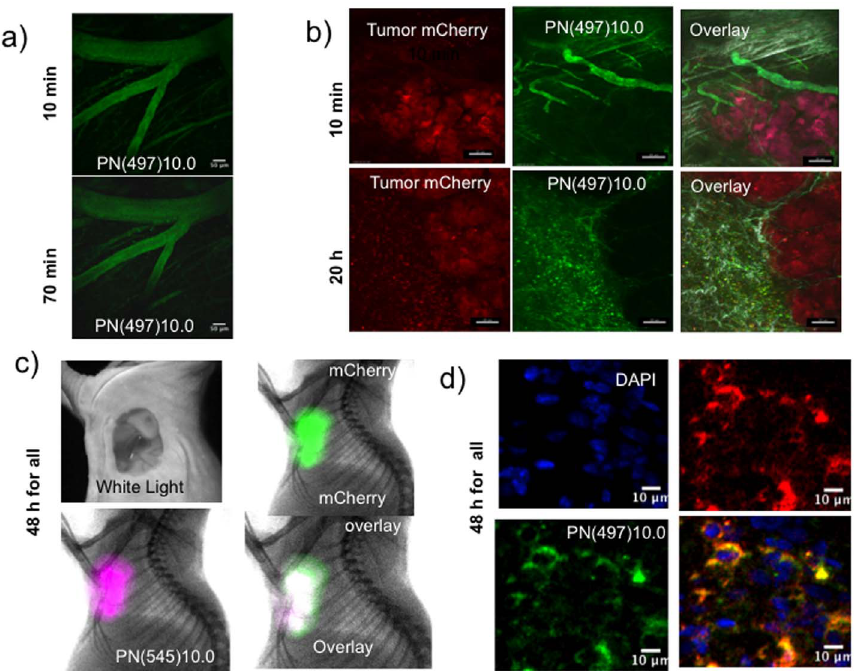
Figure 5. Fluorescent imaging of three pharmacokinetic phases of PN’s with diameters of 10 nm. A ) Vascular phase, two photon microscopy of brain vasculature of normal mice. Mice underwent a craniotomy and implantation of a transparent window. Vessel intensity drops due vascular escape, but there is no interstitial fluorescence in the brain due to the blood brain barrier. Scale marker=50 microns. B ) Intravital confocal microscopy of the vascular and interstitial phases of an mCherry expressing HT-29 xenograft. During the vascular phase (10 min post-injection), vessels are imaged, without interstitial fluorescence. During the interstitial phase (20 h post-injection), interstitial fluorescence is prominent. Scale marker=20 microns. C ) Surface fluorescence/X-ray imaging of the tumor retention phase of PN(545)10.0. Shown are the HT-29/mCherry tumor with the skin removed as a white light image, mCherry tumor fluorescence (green), PN(545)10.0 fluorescence (purple) and the green/purple over lay (white). D ) Confocal microscopy of the tumor retention phase of PN(497)10.0. Shown are a sectioned HT-29 mCherry expressing tumor with nuclei stained blue (DAPI), mCherry tumor cells (red), PN(497)10.0 (green) and a green/red overlay (yellow).